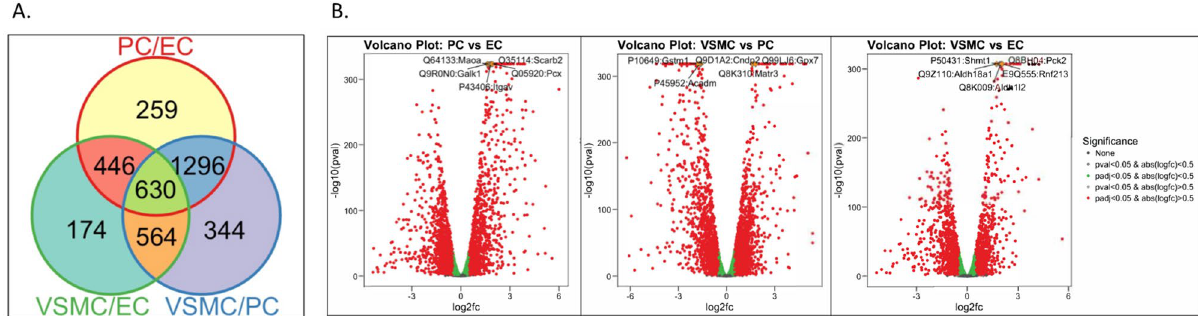
Figure 5. Differential protein profiles of cultured ECs, PCs, and VSMCs. ( A ) VENN diagram depicting number of proteins unique to, and shared between, the 3 cell types. ( B ) Volcano plots showing differential protein expression between cell types, plotting statistical significance (-log10 p-values) versus magnitude of change (Log 2 FC), n =